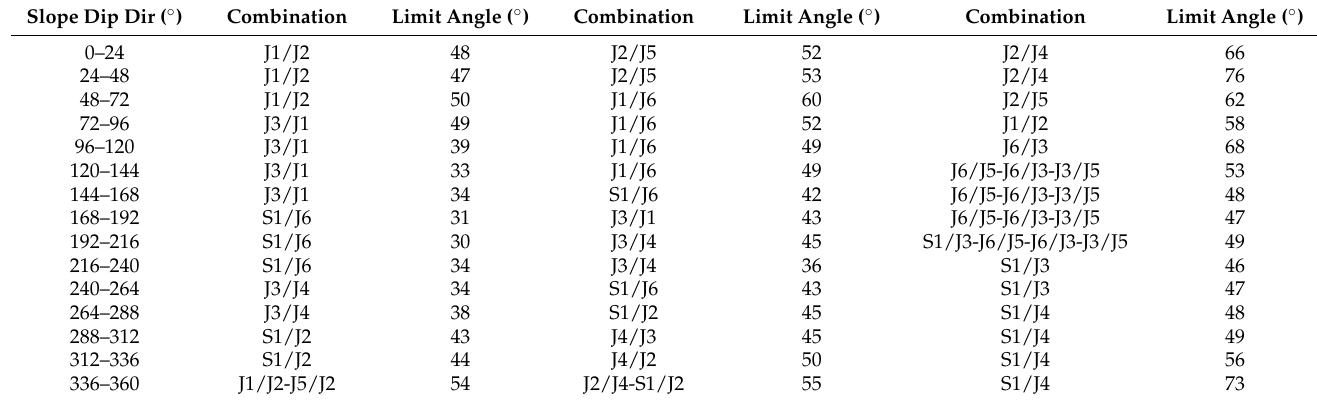
Table 7. Kinematic stability analysis results: wedge sliding.